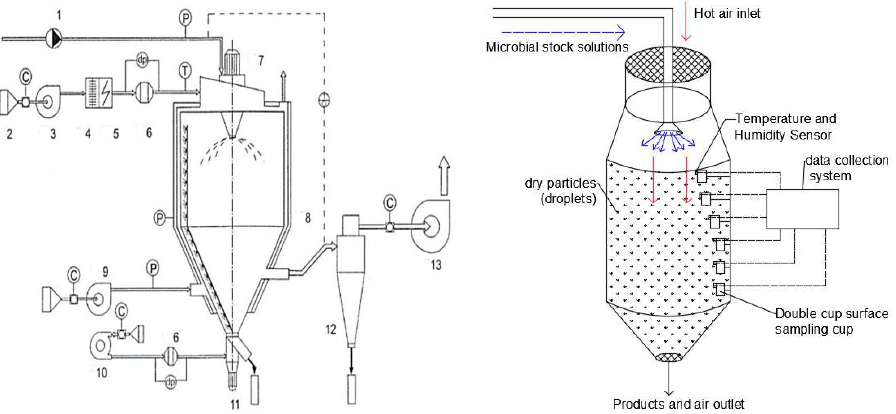
Figure 4. Schematic of the parallel flow drying column structure. (1) Feed pump, (2) & (6) Filter, (3) & (9) Fan feeders, (4) Steam heaters, (5) Electric heaters, (7) Nebulizers, (8) Drying column, (10) Air pump, (11) Gas sweep device, (12) Cyclone separator.